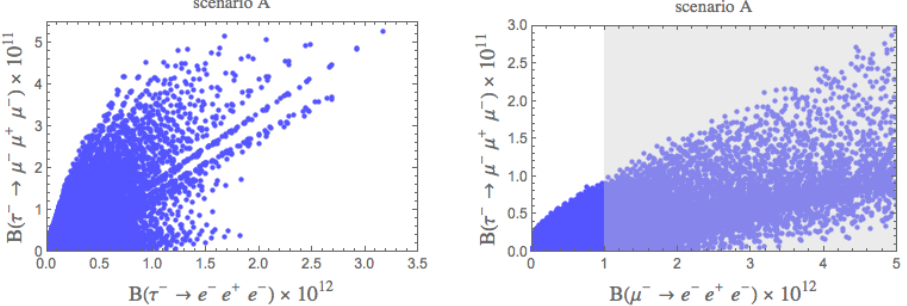
Figure 3 . Scenario A. Correlation between B ( (cid:28) (cid:0) ! (cid:22) (cid:0) (cid:22) + (cid:22) (cid:0) ) and B ( (cid:28) (cid:0) ! e (cid:0) e + e (cid:0) ) (left panel) and between B ( (cid:28) (cid:0) ! (cid:22) (cid:0) (cid:22) + (cid:22) (cid:0) ) and B ( (cid:22) (cid:0) ! e (cid:0) e + e (cid:0) ) (right panel). The gray shaded region in the right panel is excluded by the experimental bound B ( (cid:22) (cid:0) ! e (cid:0) e + e (cid:0) ) < 1 (cid:1) 10 (cid:0) 12 .